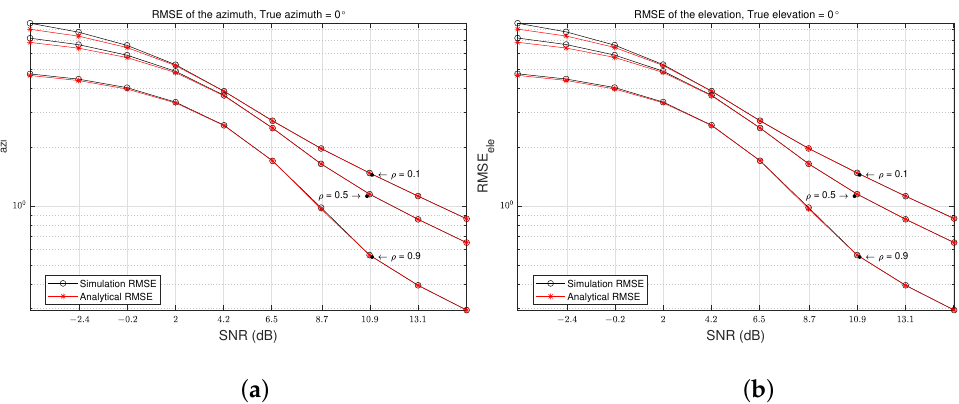
Figure 5. RMSE when the target and noise source are located on-axis (low SNR). ( a ) RMSE of ˆ θ azi . ( b ) RMSE of ˆ θ ele